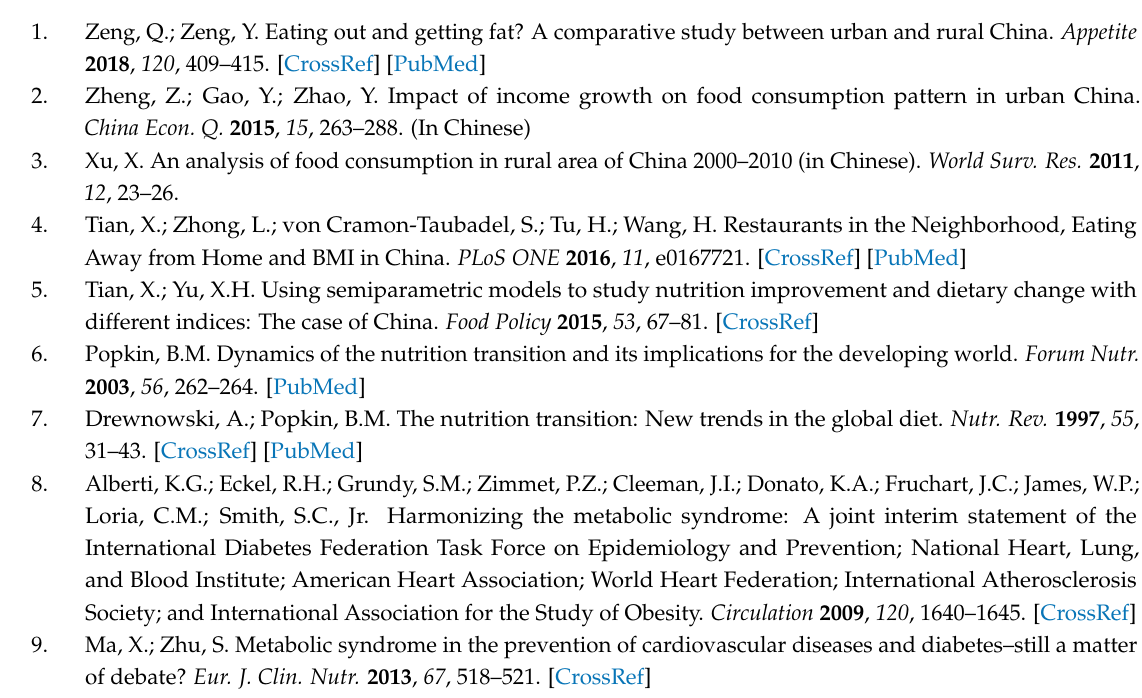
of ijerph . Figure S1: Selection of sample in the study. Figure S2: Association between predicted risk of getting metabolic syndrome and age. Table S1: Multivariable adjusted association between Mets and EAFH. Table S2: Multivariable adjusted association between Mets and EAFH by regions. Table S3: Frequency of various meals EAFH by age and